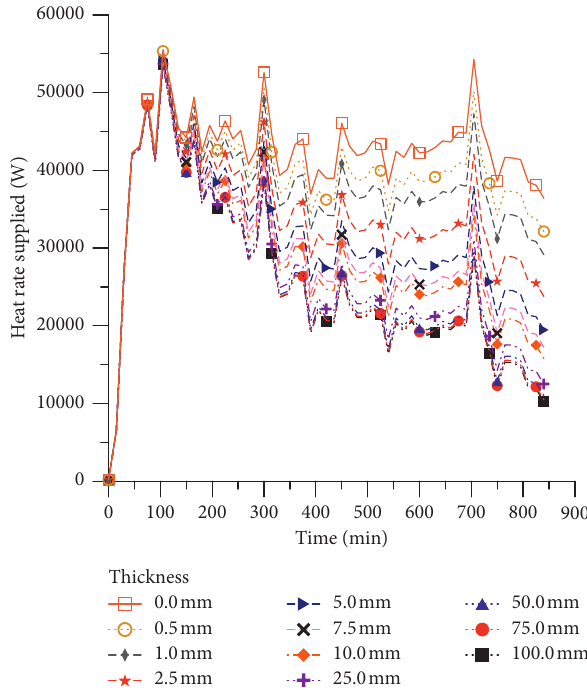
Figure 13: Heat rates supplied to the kiln during the heating process for different ceramic fiber